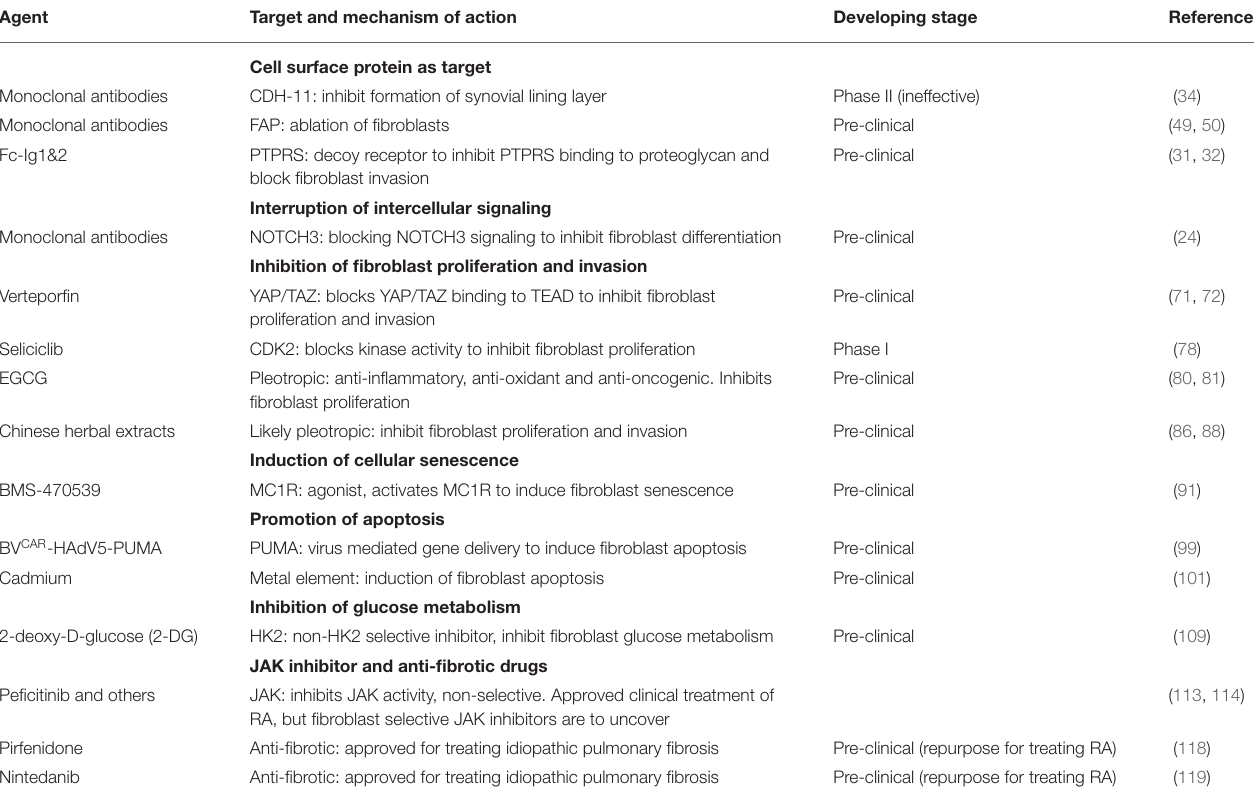
TABLE 1 | Agents for fibroblast targeted therapy for RA *